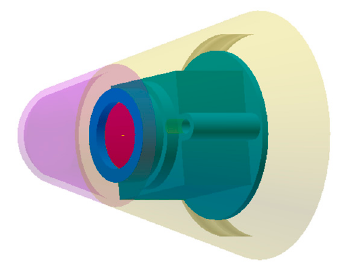
Figure 3. Composition of the infrared image system with the fuze.